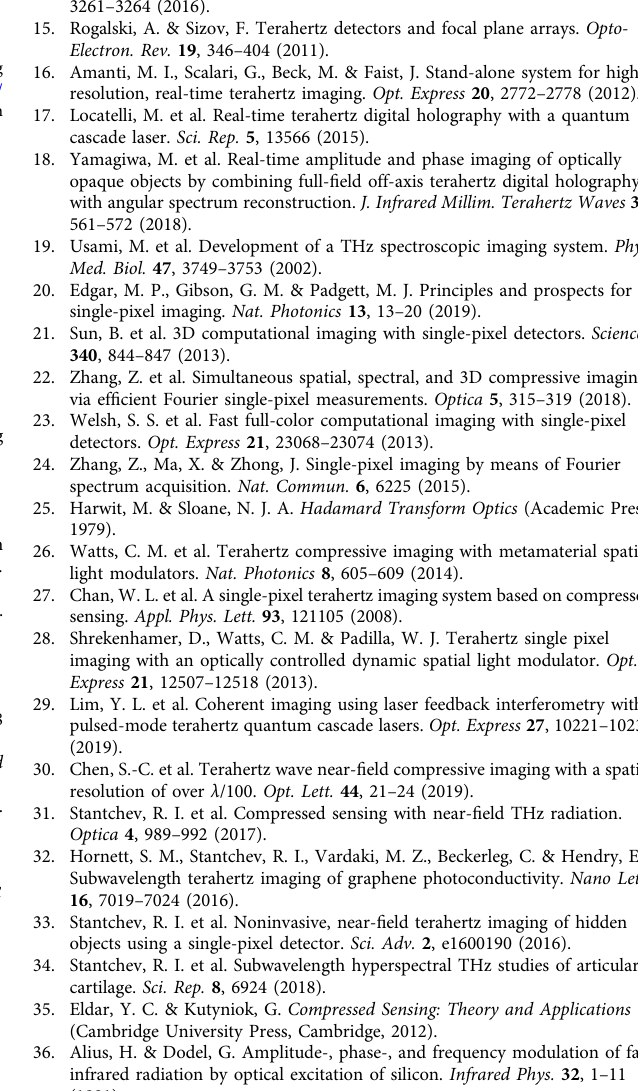
P n E ω = E ω = n , with the i Þ i ÞÞÞ i ¼ 1 unwrap ð arg ð samp ð ref ð